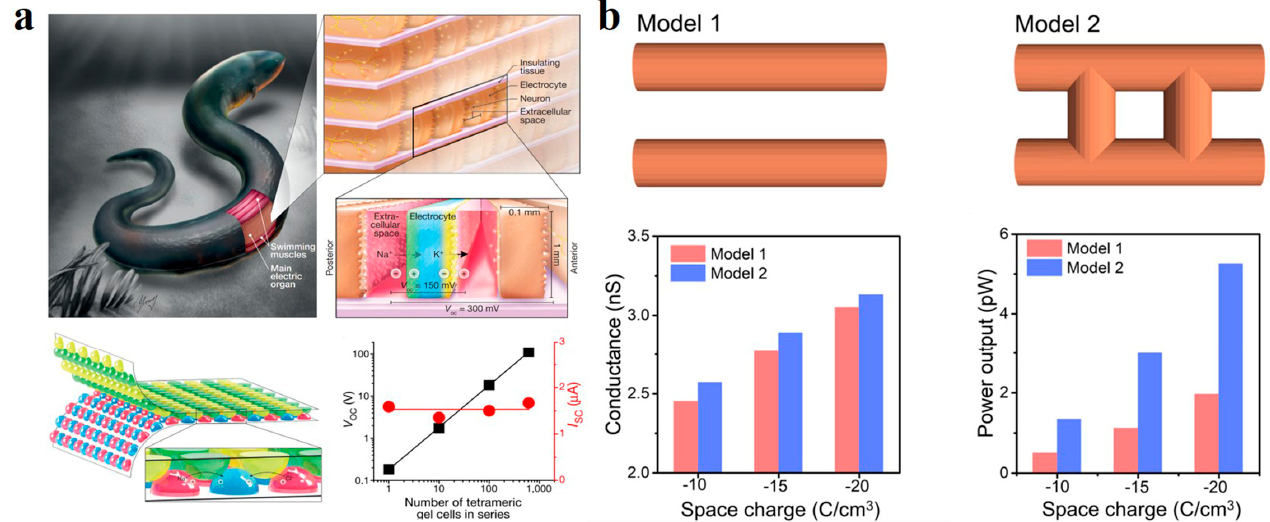
Figure 8. ( a ) A hydrogel generator that mimics an electric eel cell. Reprinted with permission from Reference [110]. ( b ) The conductivity and power output of the two channels were compared under PNP simulation. Reprinted with permission from Reference [112].